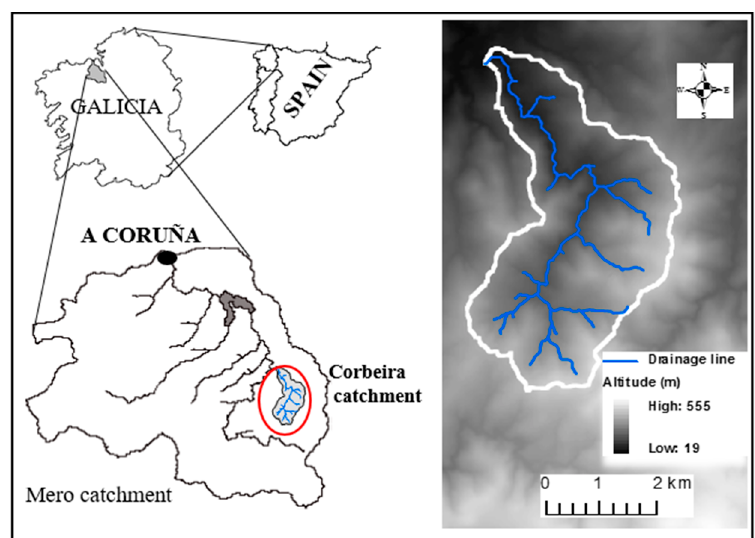
Figure 1. Location of the Corbeira catchment and Digital Elevation Model of the region.